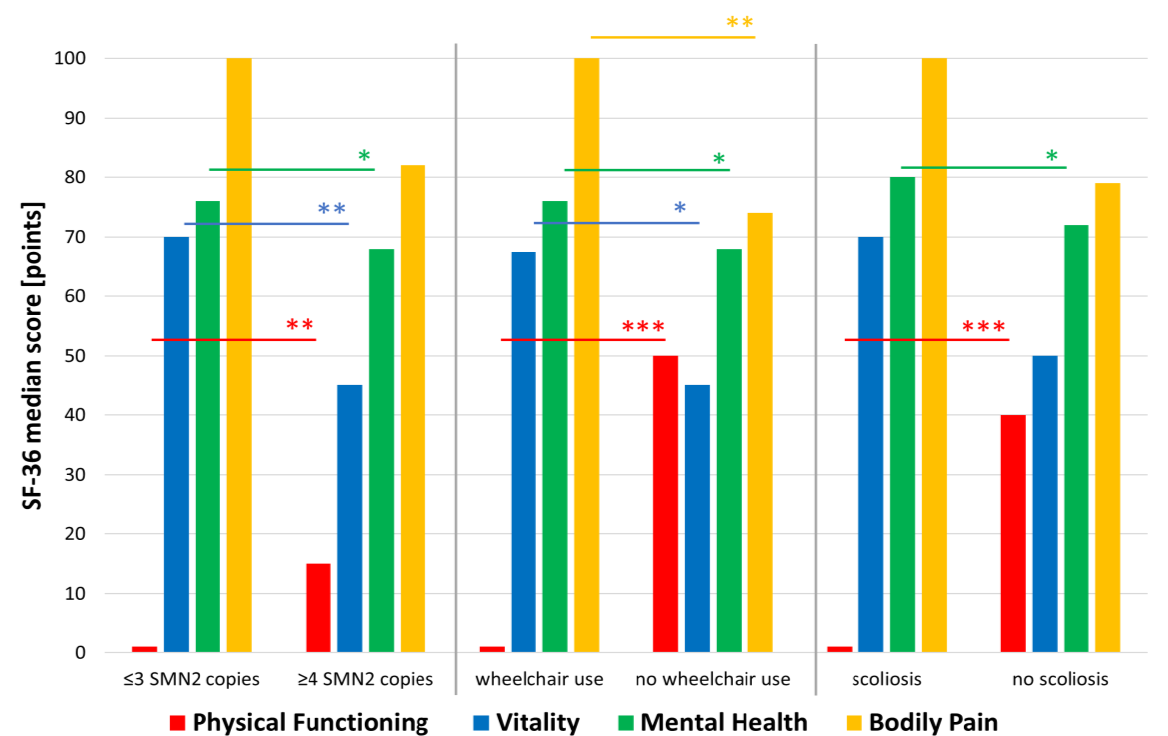
Figure 1. Association of the SF-36 dimensions Physical Functioning, Vitality, Mental Health, and Bodily Pain with patients’ characteristics. While patients with a more severe disease ( ≤ 3 SMN2 copies, wheelchair use and scoliosis) reported low scores in the dimension of Physical Functioning, they reported better Mental Health and Vitality and less Bodily Pain. Abbreviations: SMN2 = survival motor neuron 2 gene; SF-36 = Short Form Health survey 36; * p ≤ 0.05; ** p ≤ 0.01; *** p ≤ 0.001.